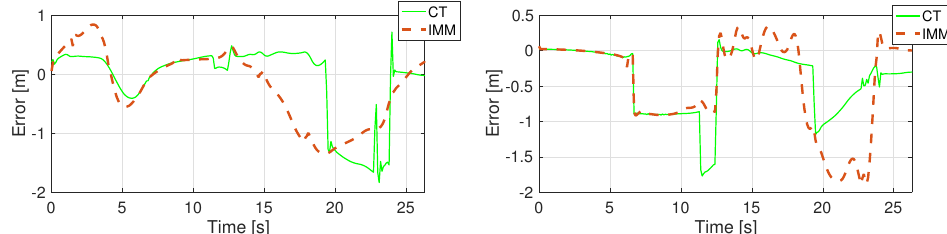
Figure 6. Position error in direction X ( left ) and Y ( right ) using the CTRV